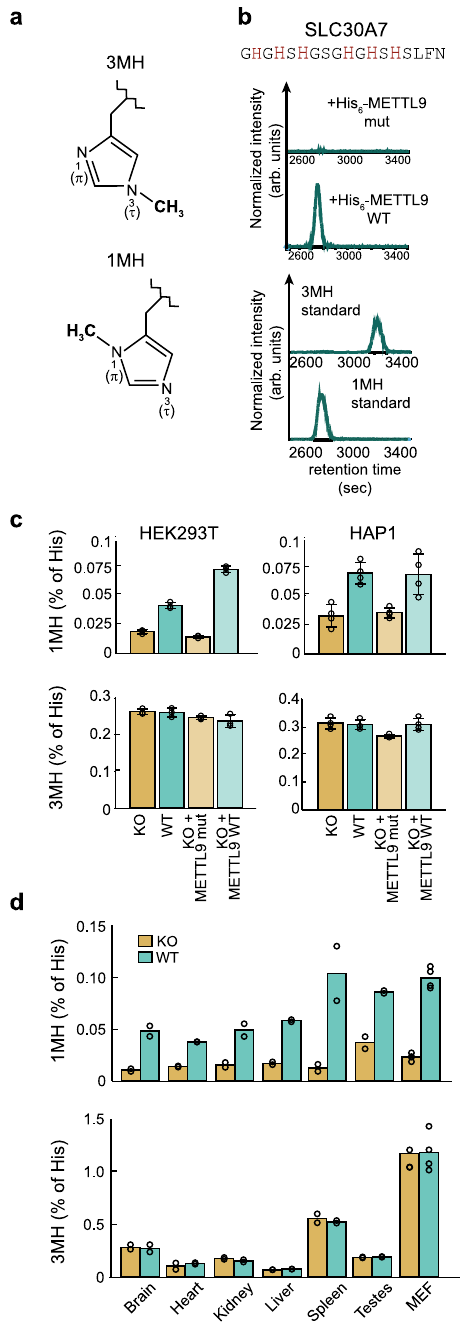
Fig. 2 METTL9 generates pervasive 1-methylhistidine in vitro and in vivo. a 3-Methylhistidine (3MH, top) and 1-methylhistidine (1MH, bottom). Polypeptide backbone indicated by jagged line. b Methylhistidine analysis of METTL9-treated SLC30A7 peptide. Shown are normalized LC/MS chromatograms of His 6 -hMETTL9-treated samples subjected to acid hydrolysis, as well as of methylhistidine standards. c Proteinaceous 3MH and 1MH in HEK293T and HAP1 cells. WT (teal bars), METTL9 KO (KO, orange bars), KO complemented with WT (KO + METTL9 WT, light teal) or mutant METTL9 (KO + METTL9 mut, light orange). Note that for HAP1 cells, the complementation is with hMETTL9-3xFLAG and the inactivating mutation is E174A, whereas for HEK293 cells, the complementation is with mMETTL9-HA and the inactivating mutation is D151K/G153R. Mean ± s.d ( n = 3 (HEK293) or 4 (HAP1) biologically independent samples). d Proteinaceous 3MH and 1MH in WT or Mettl9 KO mouse tissues and MEF cells. Mean with individual values of duplicates (tissues) or triplicates (MEF). Source data are provided as a Source Data